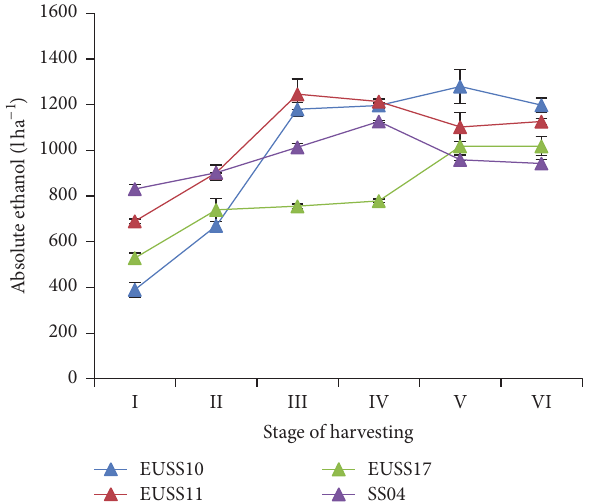
Figure 7: Effect of harvesting stage on ethanol yield of four sweet sorghum genotypes in western Kenya.